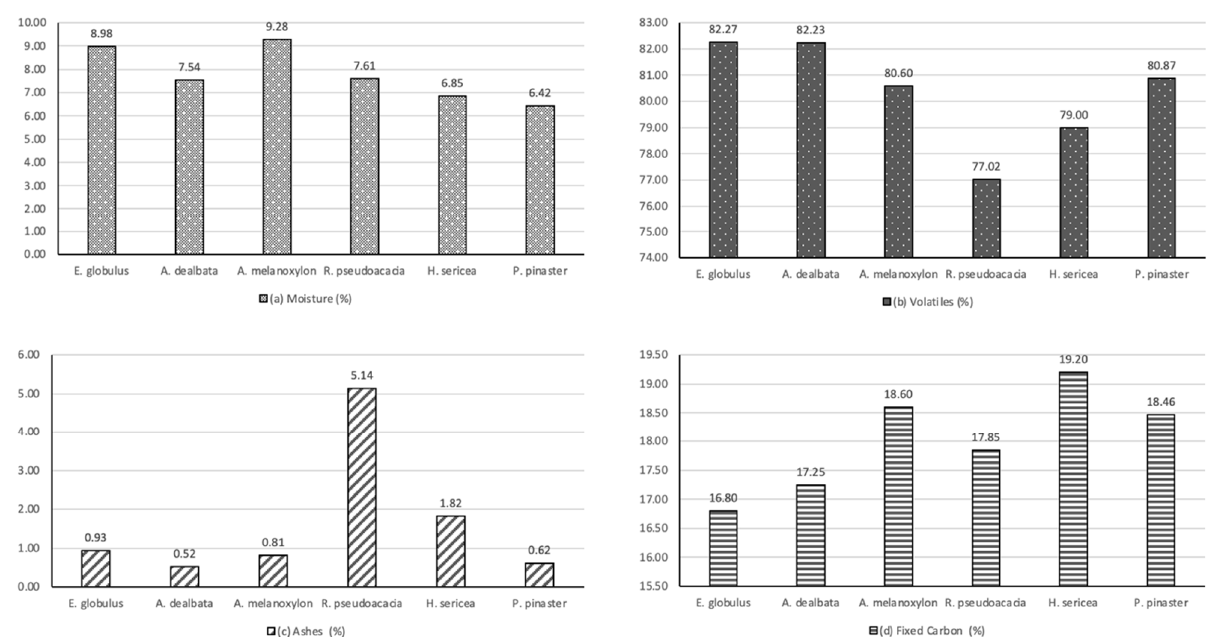
Figure 2. Results of the thermogravimetric analysis.